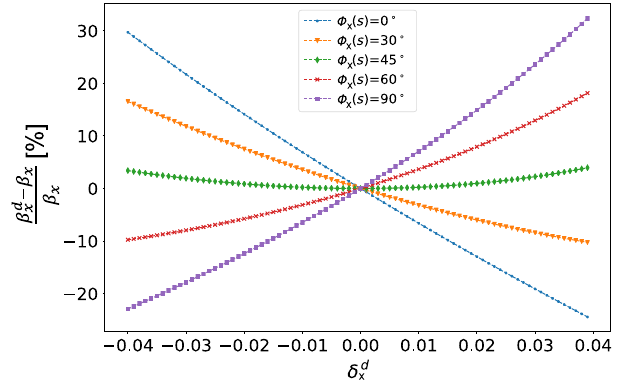
FIG. 6. ac-dipole horizontal β -beating induced effect as a function of δ d x for different phase advances between the ac dipole and a given location in the ring, ϕ x (s) for a nominal tune of